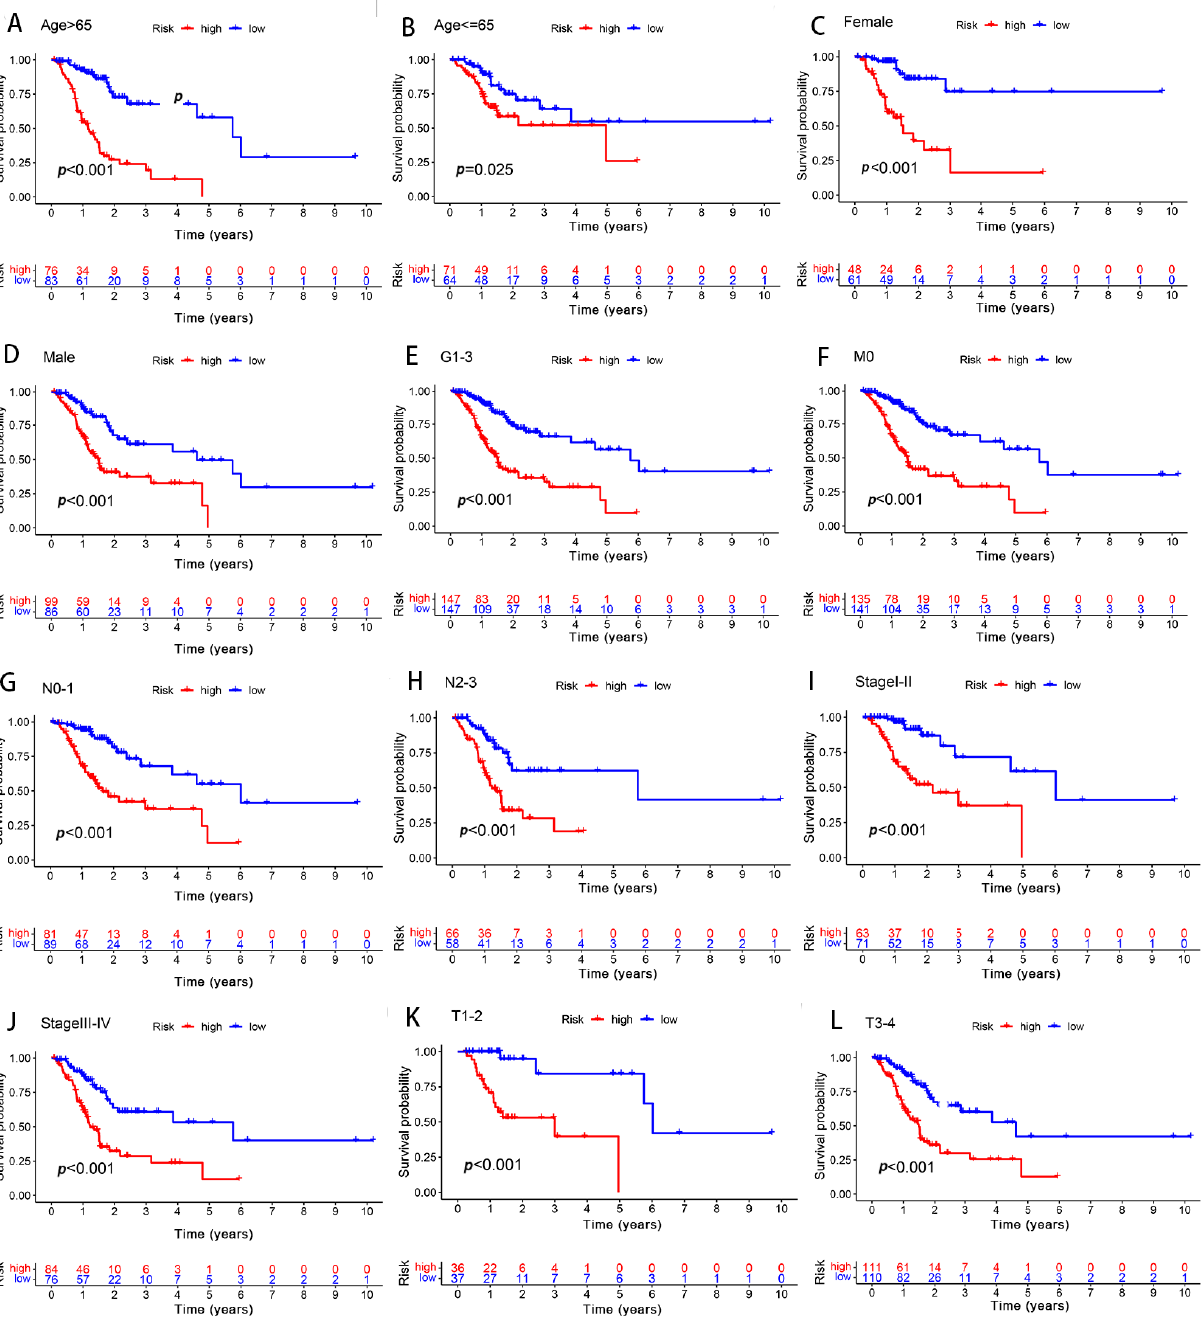
Figure 7. Differences in survival between the high- and low-risk groups, as grouped based on the different clinicopathological variables. ( A , B ) Age. ( C , D ) Sex. ( E ) Grade. ( F ) M stage. ( G , H ) N stage. ( I , J ) stage. ( K , L ) T stage.